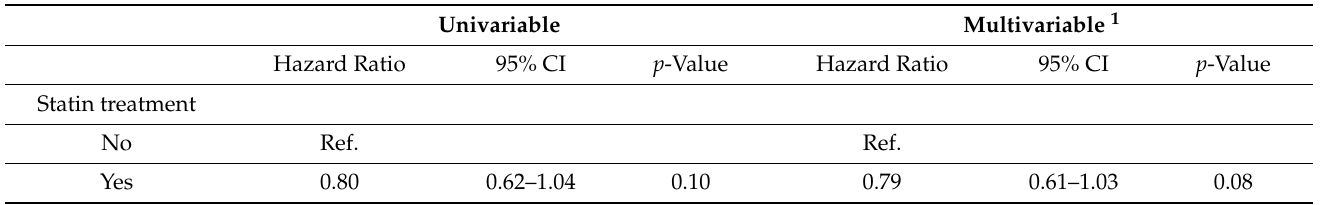
Table 2. Univariable and multivariable Cox regression models predicting biochemical recurrence within the overall study population, stratified according to statin